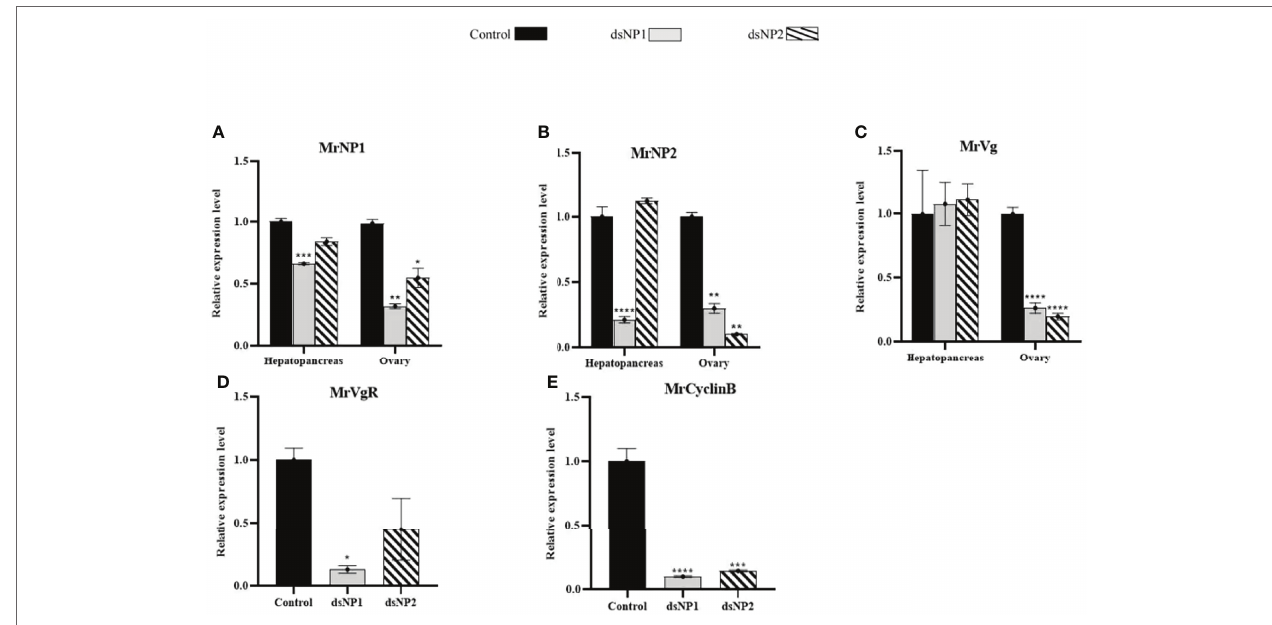
FIGURE 7 | In vitro RNA interference of dsMrNP1 and dsMrNP2. Expression of (A) MrNP1, (B) MrNP2, and (C) MrVg after shrimp hepatopancreas and ovary fragments were treated with dsTFV (black bar), dsMrNP1 (gray bar), and dsMrNP2 (diagonally stripe bar); expression of VgR (D) and CyclinB (E) after RNAi. Data were mean relative expression levels ± SD. One-way ANOVA method was used in the statistical analysis. The significance levels are: * , (P < 0.05); **, (P < 0.01); ***, (P < 0.005); and ****,